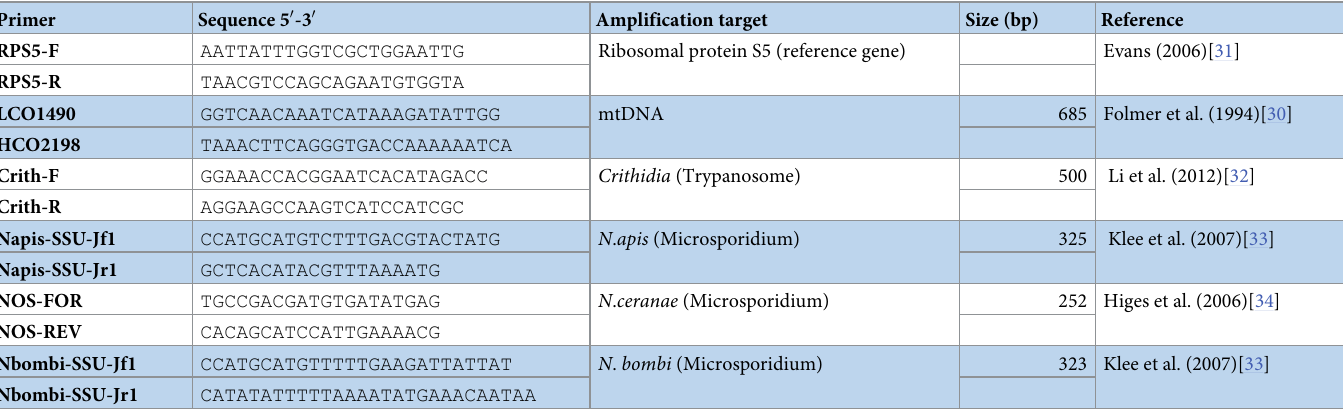
Table 2. Primers used for pathogen/parasite and mtDNA detection.